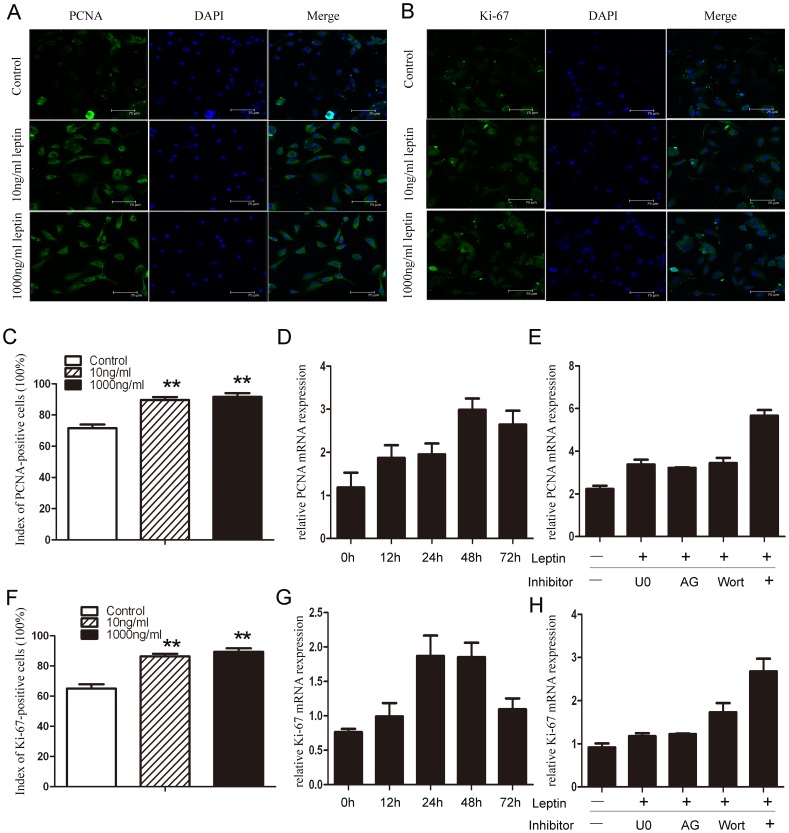
Leptin induces NP cells’cyclin D1 expression and pharmacological inhibitors of JAK, PI3K/Akt, and MEK/ERK1/2 prevent NP cells’cyclin D1 expression from leptin induction.(A) After 1-day serum deprivation, NP cells were incubated in serum-free media containing 10 ng/ml leptin for varying time intervals (12–96 h), and then the amouts of cyclin D1 protein were detected with western blotting analysis using GAPDH as an internal control. (B) NP cells were serum starved for 24 h, and then treated with vehicle (−), 10 ng/ml leptin (+), 10 µM U0126 (U0), 40 µM AG490 (AG) or 250 nM wortmannin (Wort) for 48 h. The amouts of cyclin D1 protein were detected with western blotting analysis using GAPDH as an internal control. (C) Real-time RT-PCR analysis of cyclin D1 mRNA expression in NP cells following leptin treatment for 0, 12, 24, 48 h, 72 h, or 96 h. Real-time RT-PCR analysis was performed in triplicate and the expression levels of cyclin mRNAs were normalized to GAPDH mRNAs. Error bars represent standard deviration. (D) NP cells were serum starved for 24 h, and then treated with vehicle (−), 10 ng/ml leptin (+), 10 µM U0126 (U0), 40 µM AG490 (AG) or 250 nM wortmannin (Wort) for 48 h. Cyclin D1 mRNA expression were detected with Real-time RT-PCR analysis using GAPDH as an internal control. Error bars represent standard deviration.